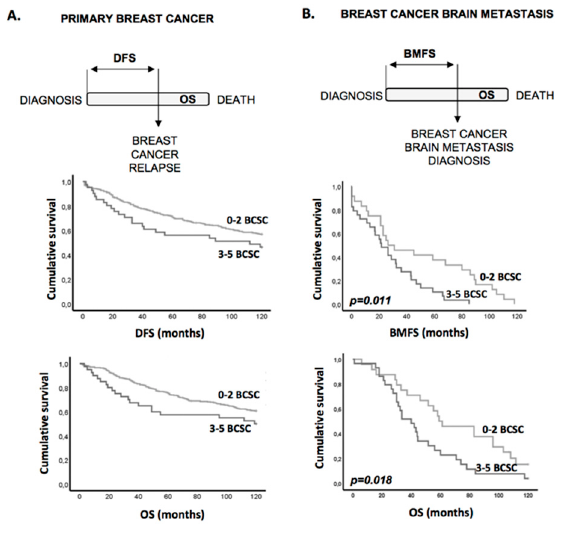
Figure 4. The BR-CSC signature associates with worse prognosis. ( A ) Kaplan–Meier analysis of disease-free survival (DFS) and overall survival (OS) using the BR-BCSC signature in the primary breast cancer series. Five-year DFS (50.2 ± 0.9 months to 43.6 ± 3.3 months, p = 0.018) and 5-year OS (52.8 ± 0.8 months to 45.1 ± 3.2 months, p = 0.004). ( B ) Kaplan–Meier analysis of brain metastases-free survival and overall survival using the SC enriched profile in the breast cancer brain metastases series. Ten-year brain metastasis free survival (BMFS) (48.1 ± 8.1 months to 26.7 ± 4.3 months, p = 0.008) and OS (68.8 ± 7.6 months to 46.2 ± 5.4 months, p =